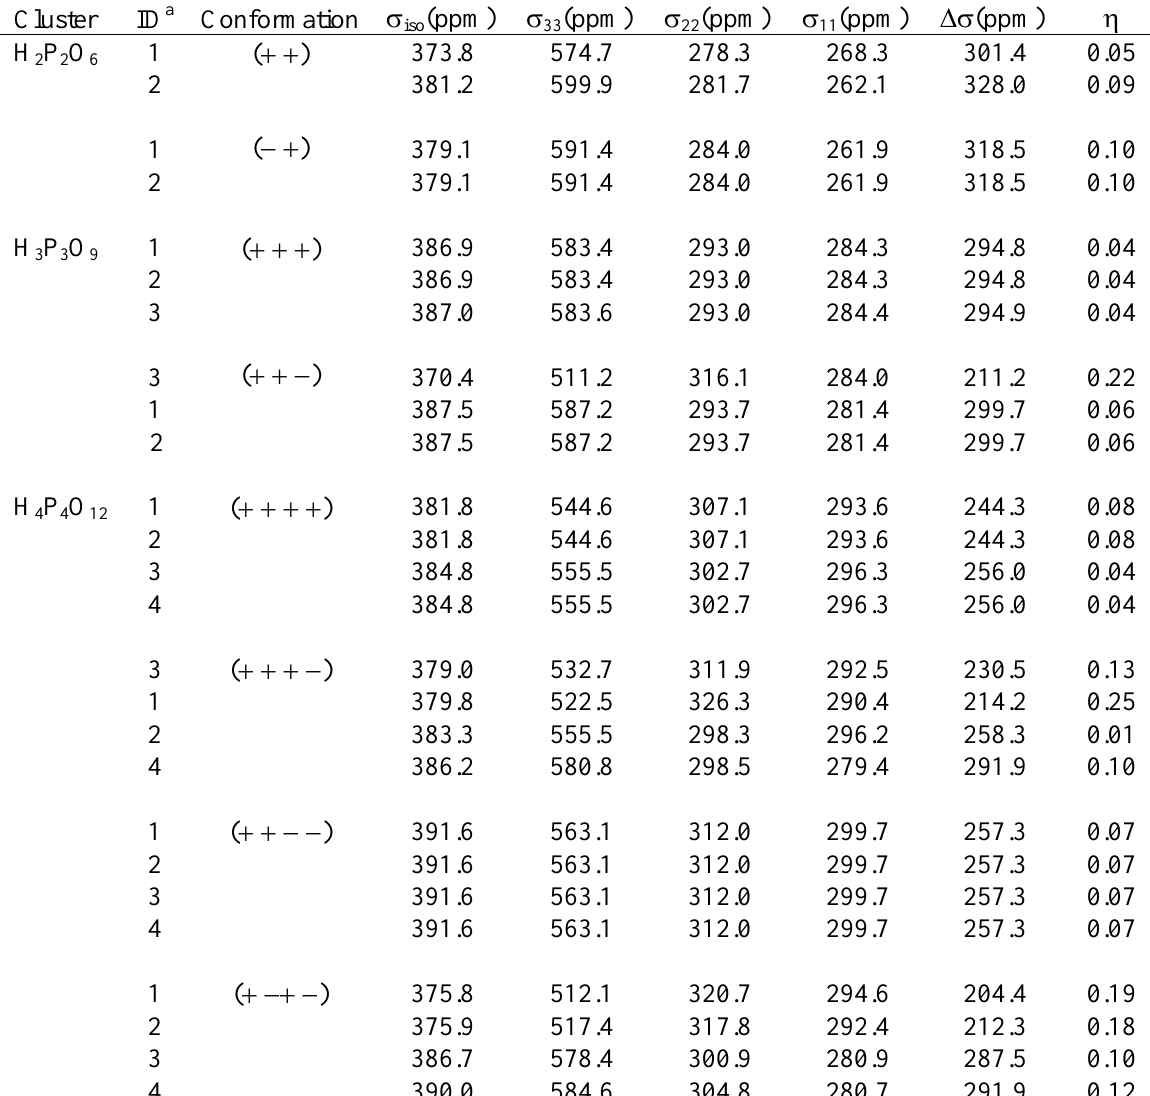
Table 2. Ab Initio NMR 31 P CSA Tensors for Cyclic 2-, 3- and 4-P Membered Phosphate Clusters. Cluster ID